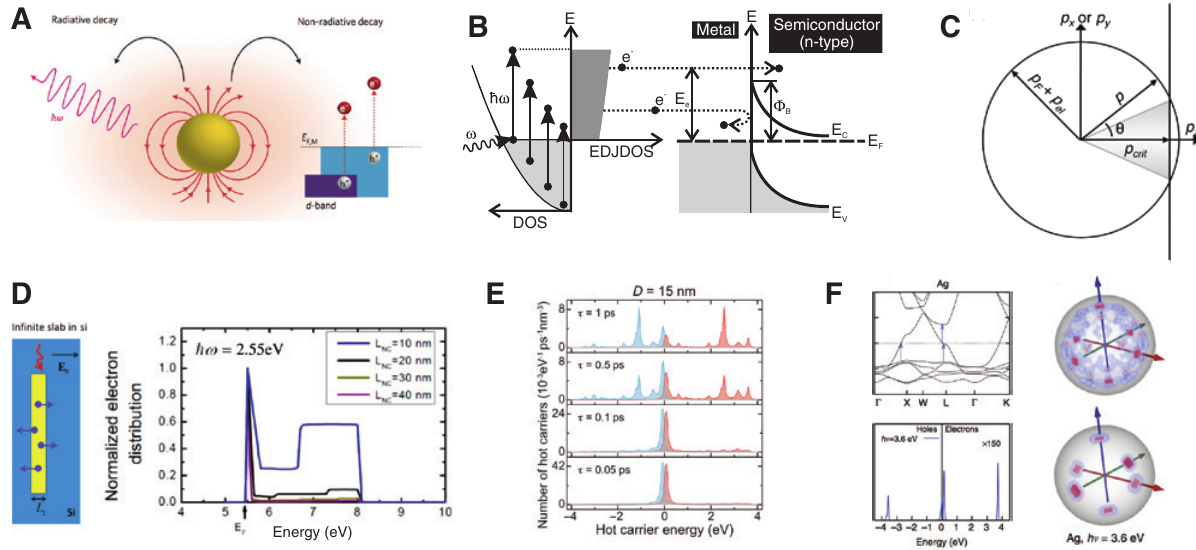
Figure 1: (A) Plasmon decay mechanism: The plasmon can either radiatively decay into reemitted photons or nonradiatively decay into hot electrons. (B) Left: Excitation of electrons in the metal from occupied energy levels in the conduction band (shaded gray) to unoc- cupied levels above the Fermi energy. Right: Energy diagram of the Schottky junction at the metal-semiconductor interface (shown for an n-type semiconductor). Hot electrons with energy larger than the Schottky barrier can be emitted over the barrier into the semiconductor. (C) Schematic showing an isotropic hot electron momentum distribution in a sphere and a limited escape cone. (D) Hot electron distribu- tions in Au slabs as a function of slab thickness. (E) Hot carrier distribution as a function of hot carrier lifetime in silver nanoparticles. Zero energy refers to the Fermi level. (F) Left: Band structures (top) and predicted plasmonic hot carrier energy distributions (bottom) for silver. Right: Anisotropic hot carrier energy (top) and momentum (bottom) distributions in silver. Figures adapted with permission from: (A) Ref. [27], © 2014 Nature Publishing Group; (B) Ref. [28], © 2012 American Institute of Physics; (C) Ref. [29], © 2014 American Institute of Physics; (D) Ref. [30], © 2013 American Chemical Society; (E) Ref. [31] © 2014 American Chemical Society; (F) Ref. [32] © 2014